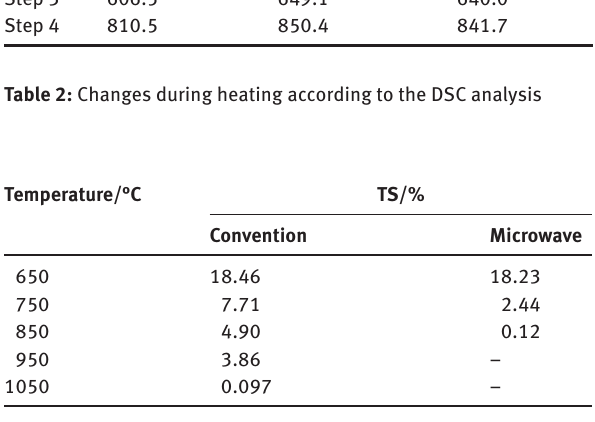
Table 3: Total sulfur of prepared sample